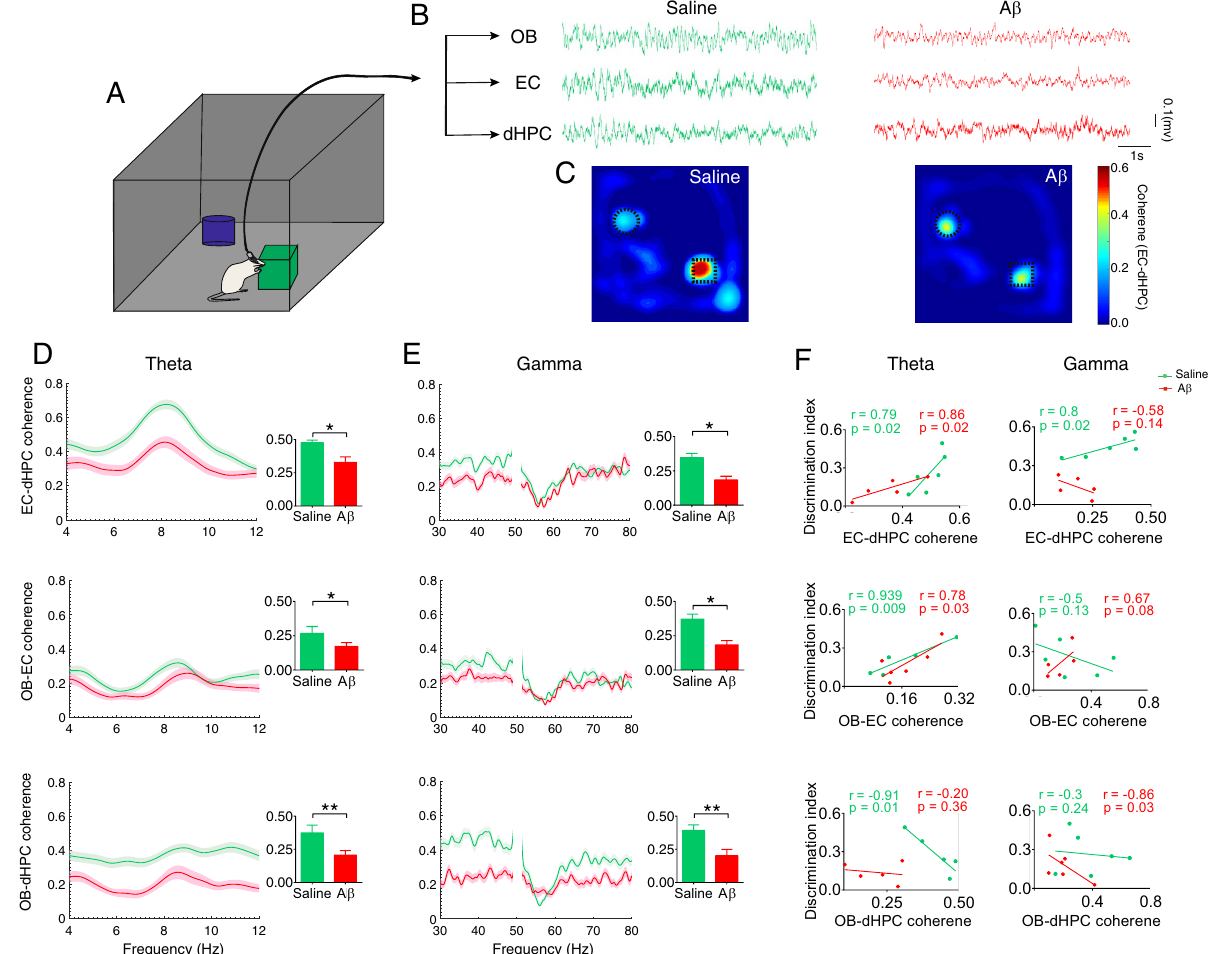
Figure 5. Aβ reduced coherence in the OB-EC-dHPC circuit during recognition memory performance. ( A ) A schematic illustration of the rat while exploring the novel object. ( B ) A representative sample of signals when animals performed NOR tasks. ( C ) A sample of EC-dHPC coherence on maze during the task. LFPs are binned into the positional frame, and the mean pixel coherence is color-coded to illustrate coherence on the maze. Darker color indicates enhanced coherence beside the novel object. ( D and E ) Coherence spectral in OB-EC- dHPC circuit at theta and gamma frequency bands, respectively. Compared to the saline group, Aβ animals showed a significant reduction in the coherence at both theta and gamma. ( F ) Correlation between recognition memory performance and OB-EC-dHPC coherence. NOR task performance (measure with discrimination index) was correlated with coherence in the OB-EC-dHPC circuit. At theta band, the correlation between NOR performance and coherence in EC-dHPC and OB-EC was positive for both groups and negative in OB-dHPC for the saline group. At the gamma band, the correlation between NOR performance and coherence in EC-dHPC was positive in the saline group. Also, in OB-EC and OB-dHPC circuits, this correlation was positive and negative for Aβ animals, respectively. Lines display the mean of coherence, and the shaded area represents SEM. Bar graphs are generated by mean values of coherence. Comparisons were made by t-test and Pearson correlation coefficients. For Pearson correlation, data were assessed regarding outliers. n = 6 per group. * p < 0.05, ** p < 0.01. Aβ amyloid-beta, OB olfactory bulb, EC entorhinal cortex, dHPC dorsal hippocampus, LFP local field potential, NOR novel object